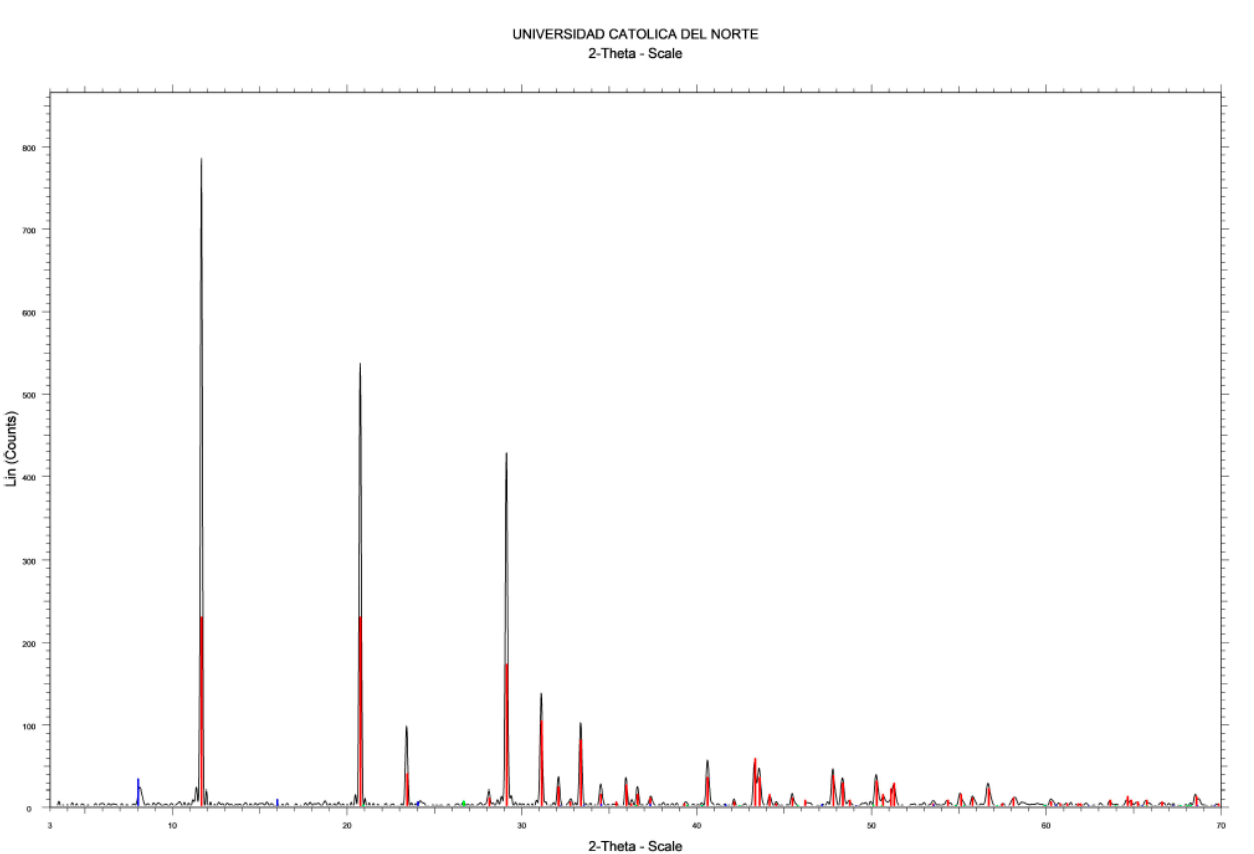
Figure 9. XRD patterns of the solids using Ca(OH) 2.